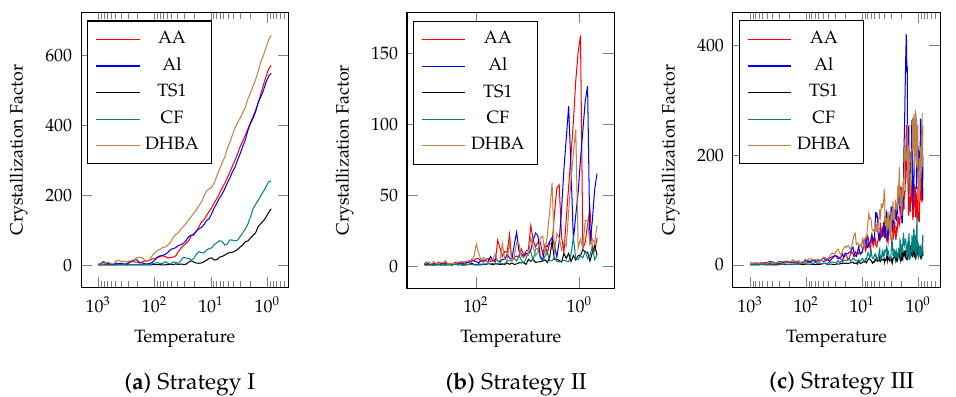
Figure 10. Crystallization factor evolution according the three positive feedback strategies. (a) En- hancing the refinement. (b) Good balance between refinement and exploration. (c) Enhancing the exploration.